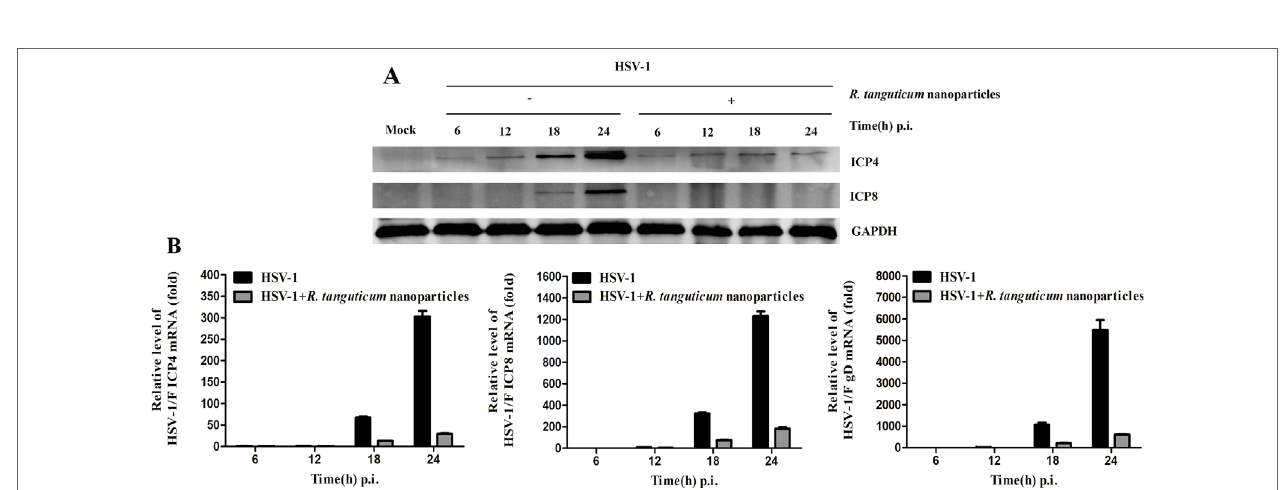
FIGURE 4 | The anti-inactivation (A) anti-attachment (B) and anti-penetration (C) activities of R. tanguticum nanoparticles. Values are represented as the mean ± standard deviation of three individual experiments. “VC” is the abbreviation of the “virus control group”.* p < 0.05; ** p < 0.01; *** p < 0.001; n.s., not significant.